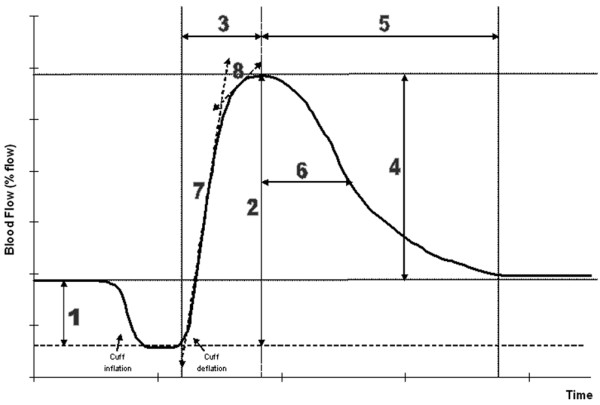
Schematic representation of reactive hyperaemia and measurements realised from laser Doppler recording. 1: Mean blood flow at rest (Φrest). 2: Peak flow (Φpeak). 3: Time to peak. 4: ΔΦ = Φpeak - Φrest. 5: Time to flow normalisation. 6: Time to half flow normalisation. 7: First upward slope calculated for the first 3 seconds. 8: Second upward slope calculated for the second half.